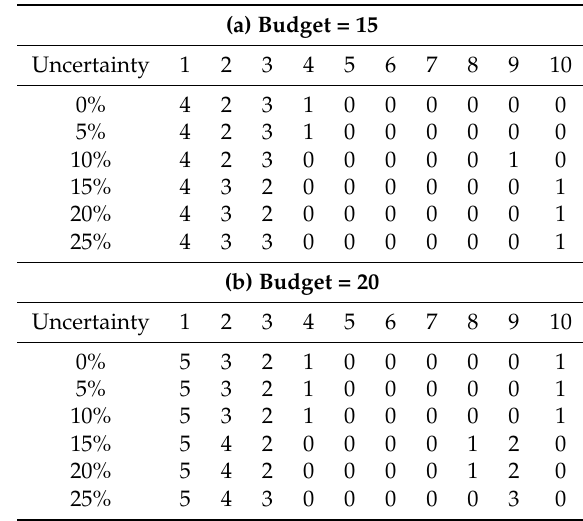
Table 2. Optimal